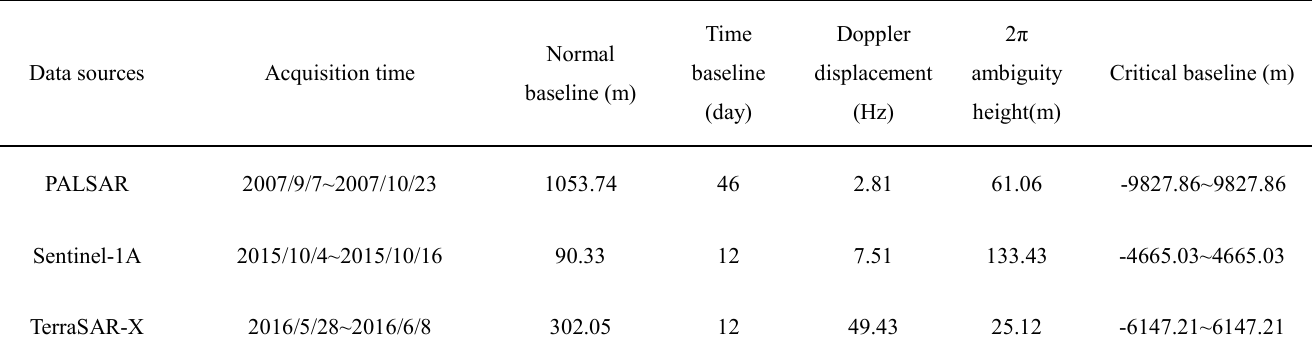
Table 2 the parameters of baseline estimation of three SAR image pairs